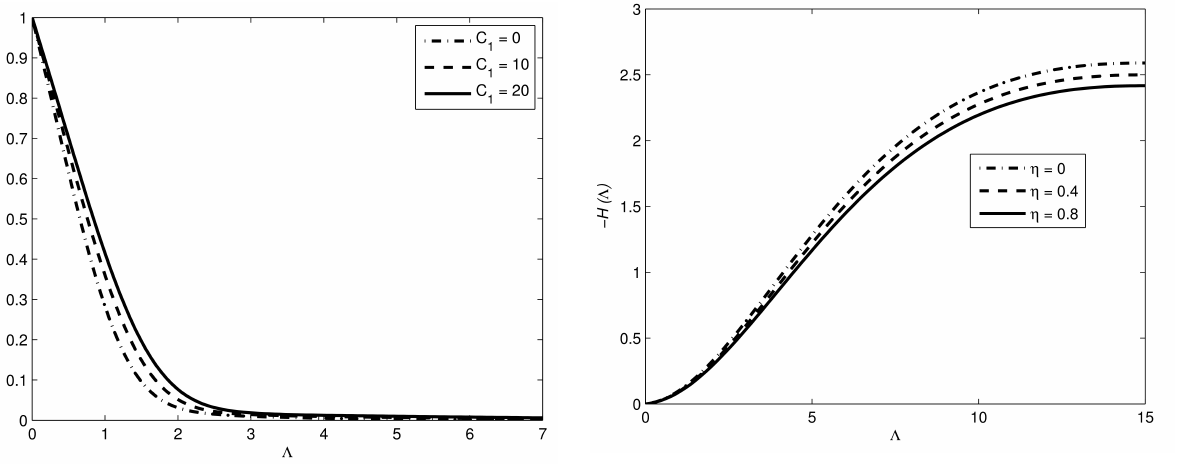
Figure 7: Effect of C 1 on θ ( Λ ) keeping ζ = η = 0.2 , C 2 = C 3 = 1 , Pr = 6.8 , Br = 1 and Re = 2950